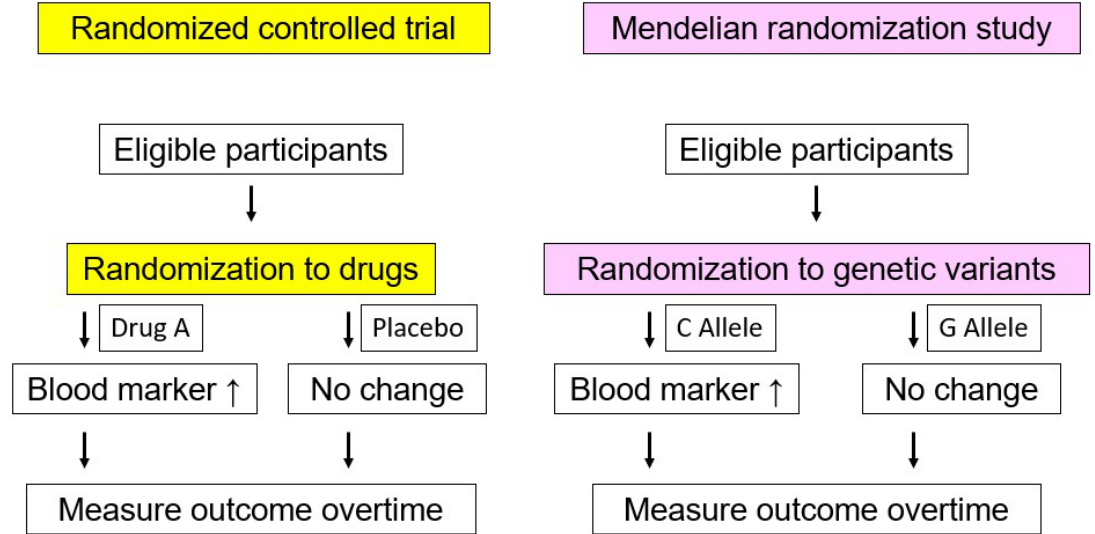
Figure 2. Scheme of randomized controlled trial and Mendelian randomization studies. The left panel indicates a randomized controlled trial. The right panel indicates a Mendelian randomized